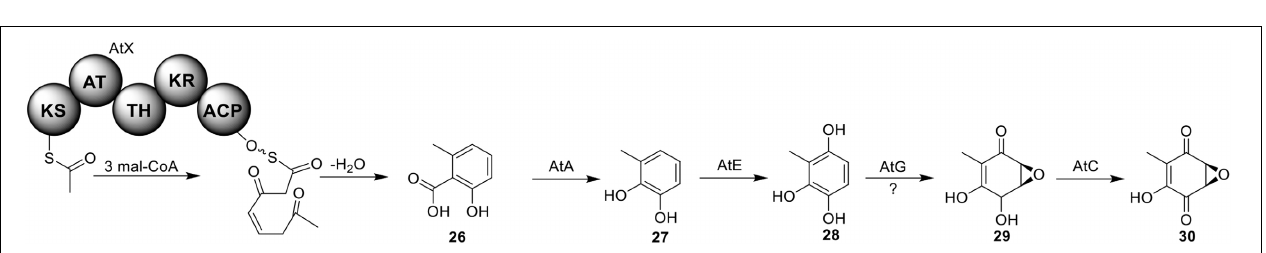
FIGURE 6 | Biosynthesis of terrein in A. terreus .